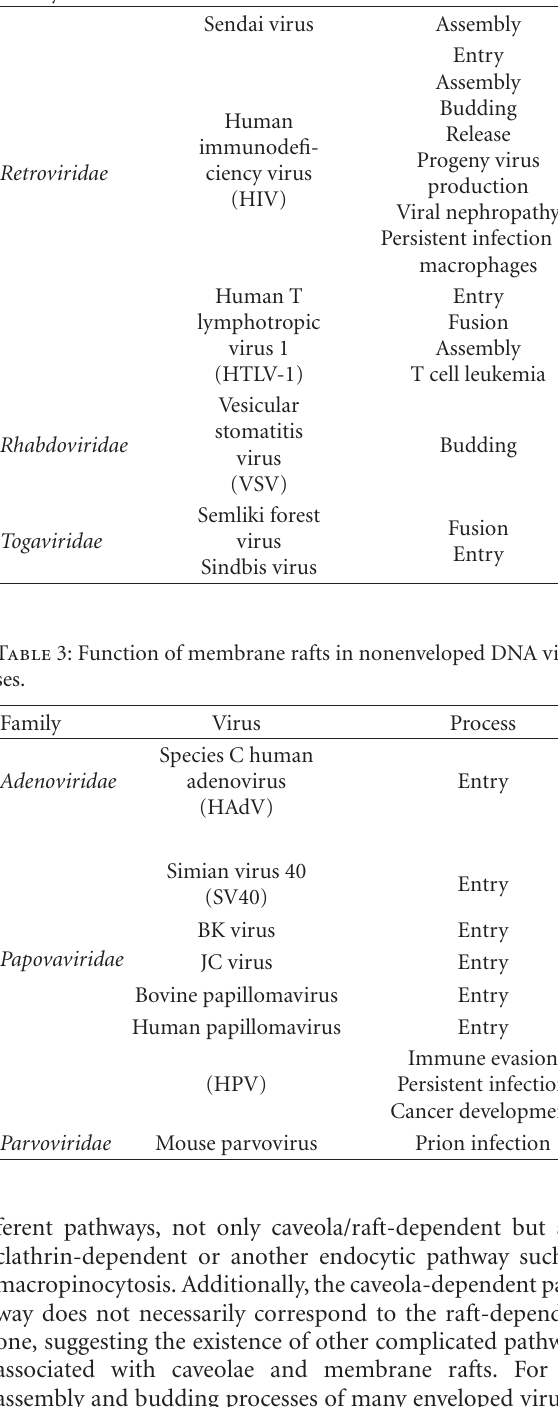
Table 4: Function of membrane rafts in nonenveloped RNA viru-